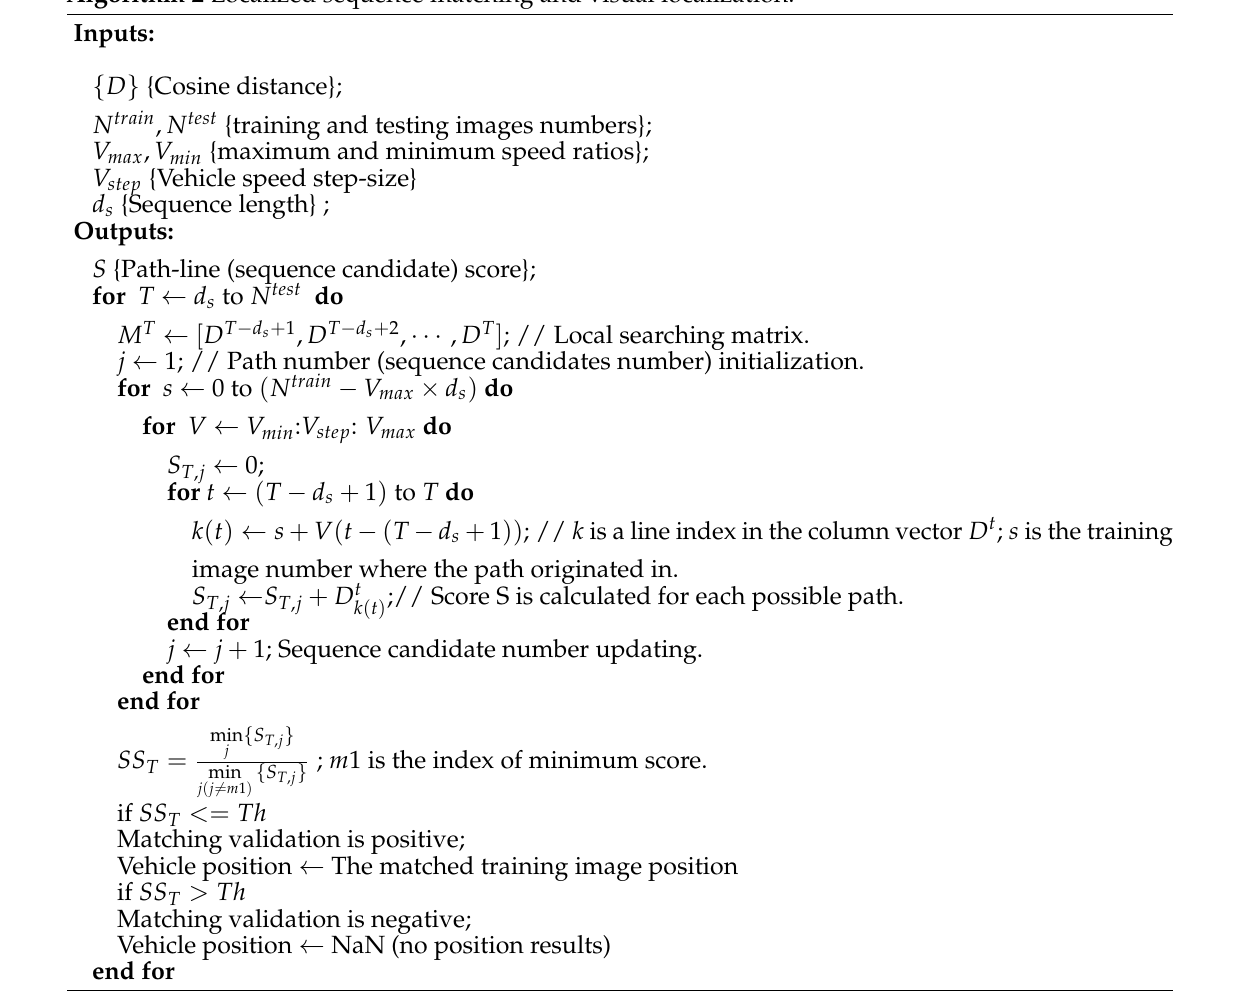
Algorithm 2 Localized sequence matching and visual